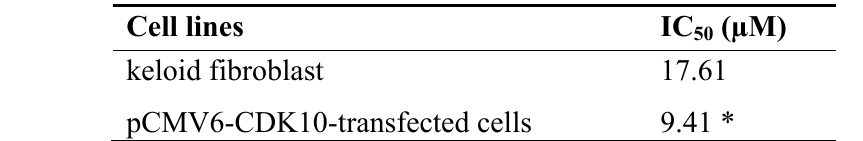
Table 1. Inhibition concentrations 50% (IC fibroblast cells and pCMV6-CDK10-transfected cells determined by MTT assay. The symbols * indicate significant differences ( p < 0.01) with respect to control (keloid fibroblast).